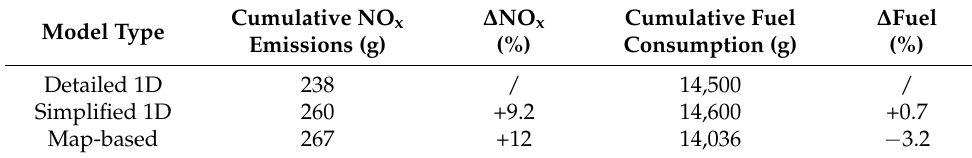
Table 4. NO x emissions and fuel consumption results.